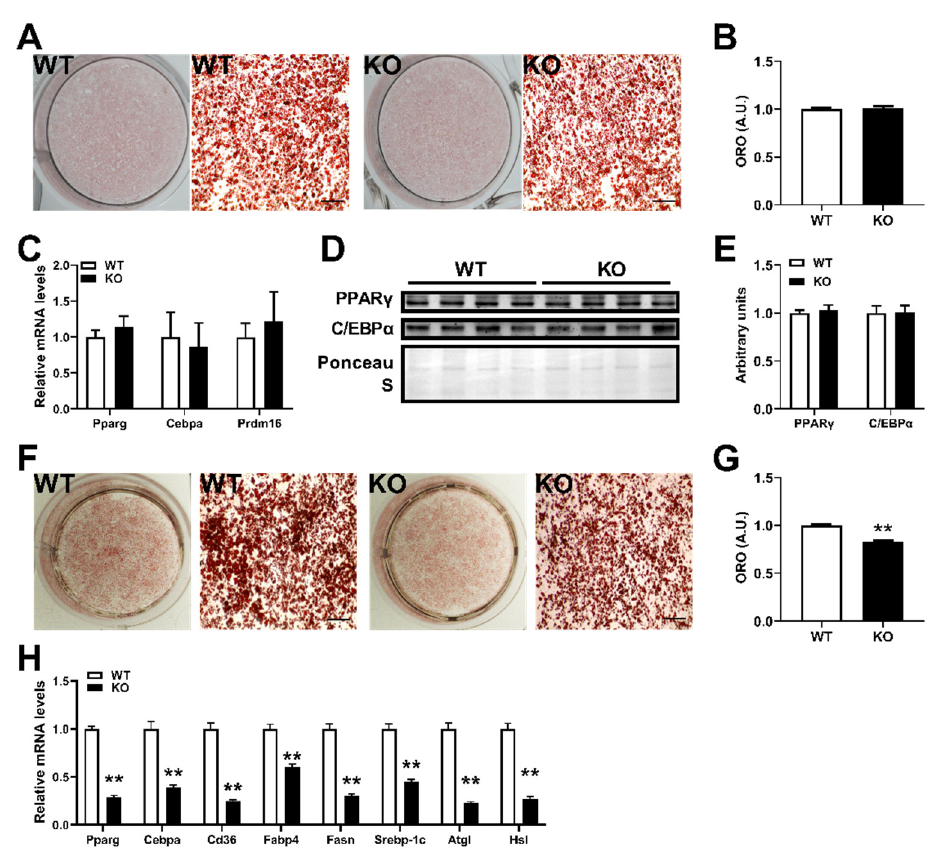
Figure 2. miR-143KO inhibits the differentiation of white adipocytes, but not brown adipocytes. ( A , B ) The Oil-Red-O staining of WT or KO brown adipocyte lipid droplets ( A ) and quantified by measuring absorbance post-isopropanol extraction of Oil Red O ( B ) (n = 3). ( C – E ) The adipogenic- related genes mRNA ( C ) (n = 6) and PPAR γ and C/EBP α protein ( D , E ) (n = 4) expression levels in the differentiated WT or KO brown adipocyte. ( F , G ) Oil red O staining of white adipocytes and statistical analysis of oil red O after isopropanol extraction (n = 3). ( H ) Lipogenesis- and lipolysis-related genes mRNA levels (n = 8). ** compared with the control group, p < 0.01.